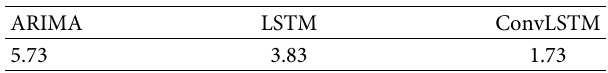
Table 1: Root mean square error of different models.